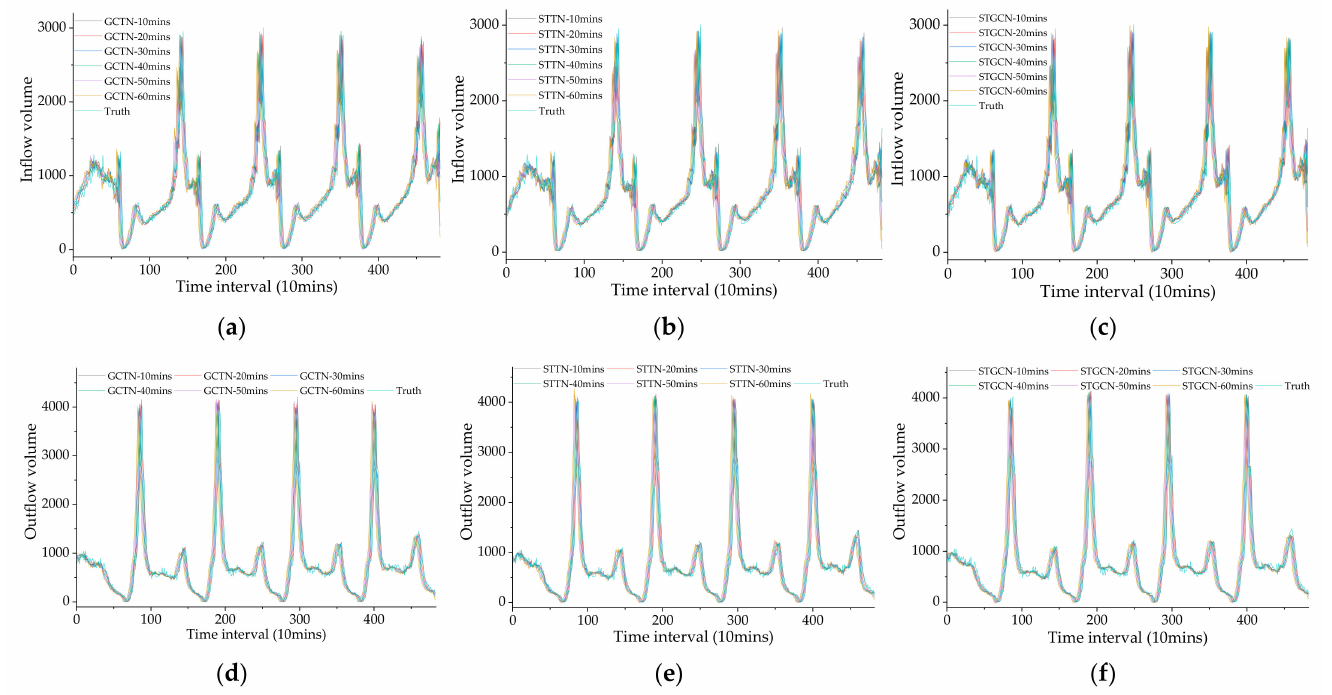
Figure 12. The visualization of long-term prediction with inflow volume and outflow volume in the Xujiahui Station of which time interval is 10 min, ( a ) GCTN inflow volume; ( b ) STTN inflow volume; ( c ) STGCN inflow volume; ( d ) GCTN outflow volume; ( e ) STTN outflow volume; ( f ) STGCN outflow